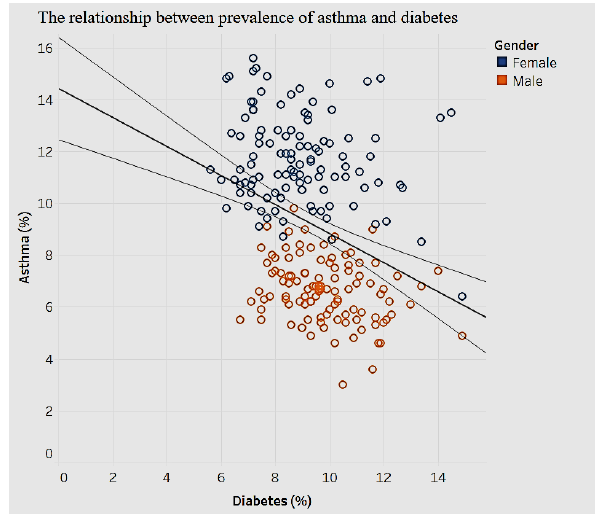
Figure 23. Asthma by diabetes.